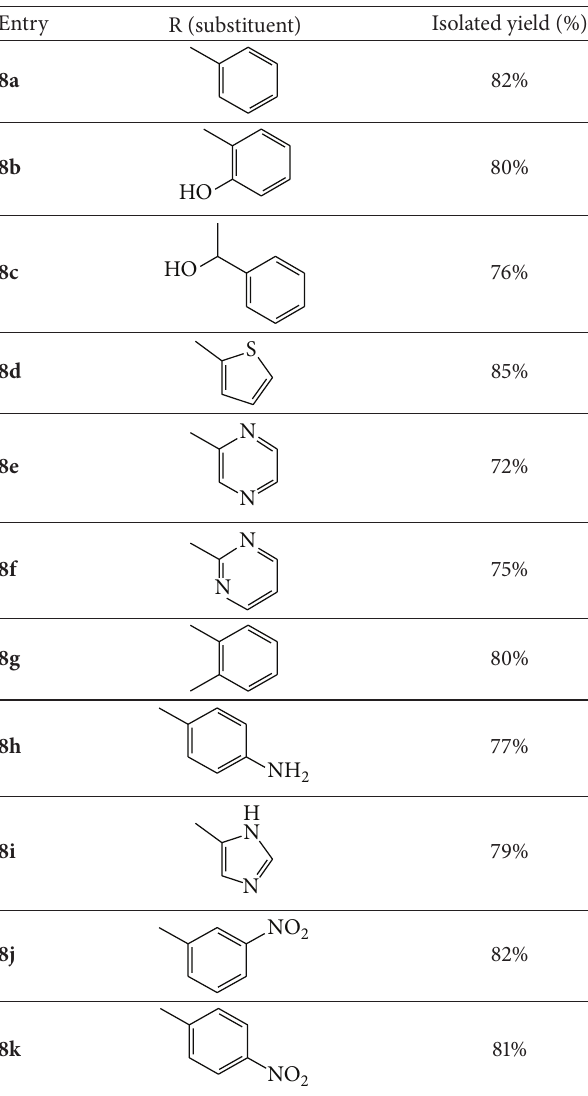
Table 1: Isolated yield of compounds 8a–k